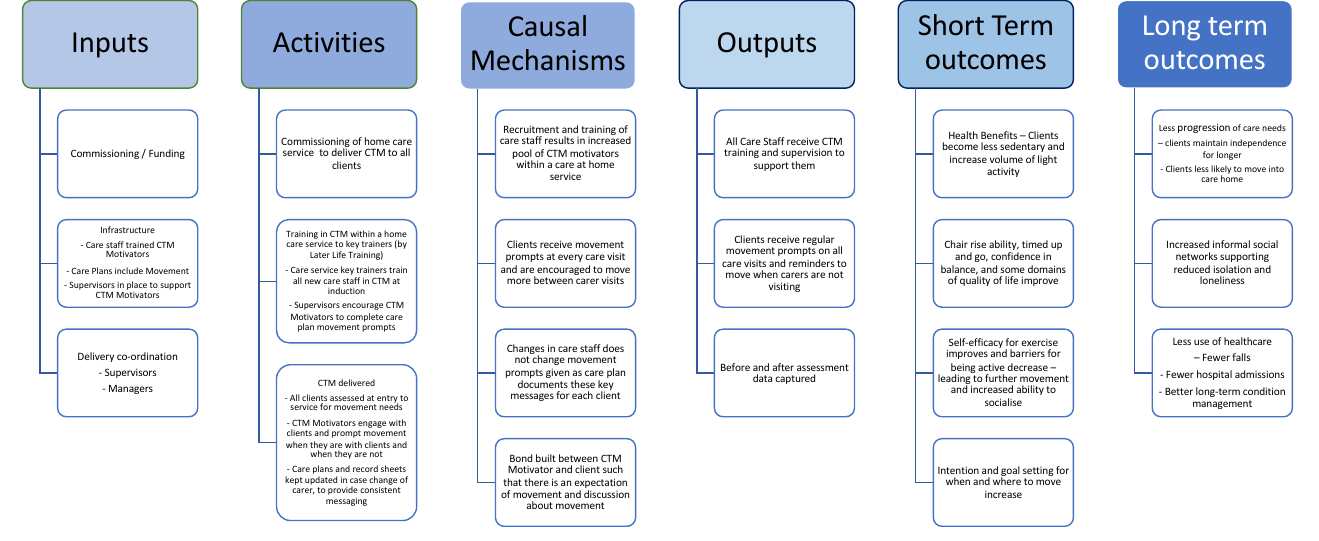
Figure 2. Logic model for CTM